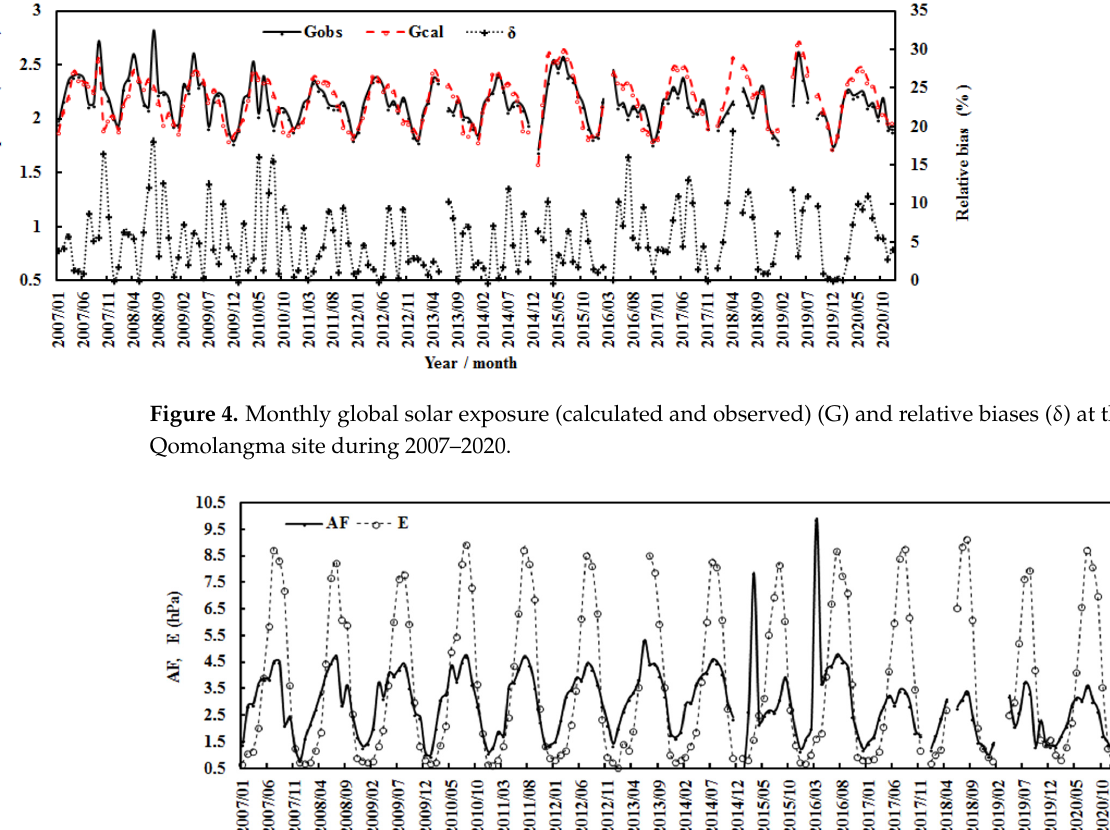
Figure 6. Annual calculated global solar exposures (G cal ), water-vapor pressure (E), and attenuation factor (AF) at the Qomolangma site during 2007–2020. The lines are linear fits to the data for E (up- per line), AF (middle line), and G cal (lower line).